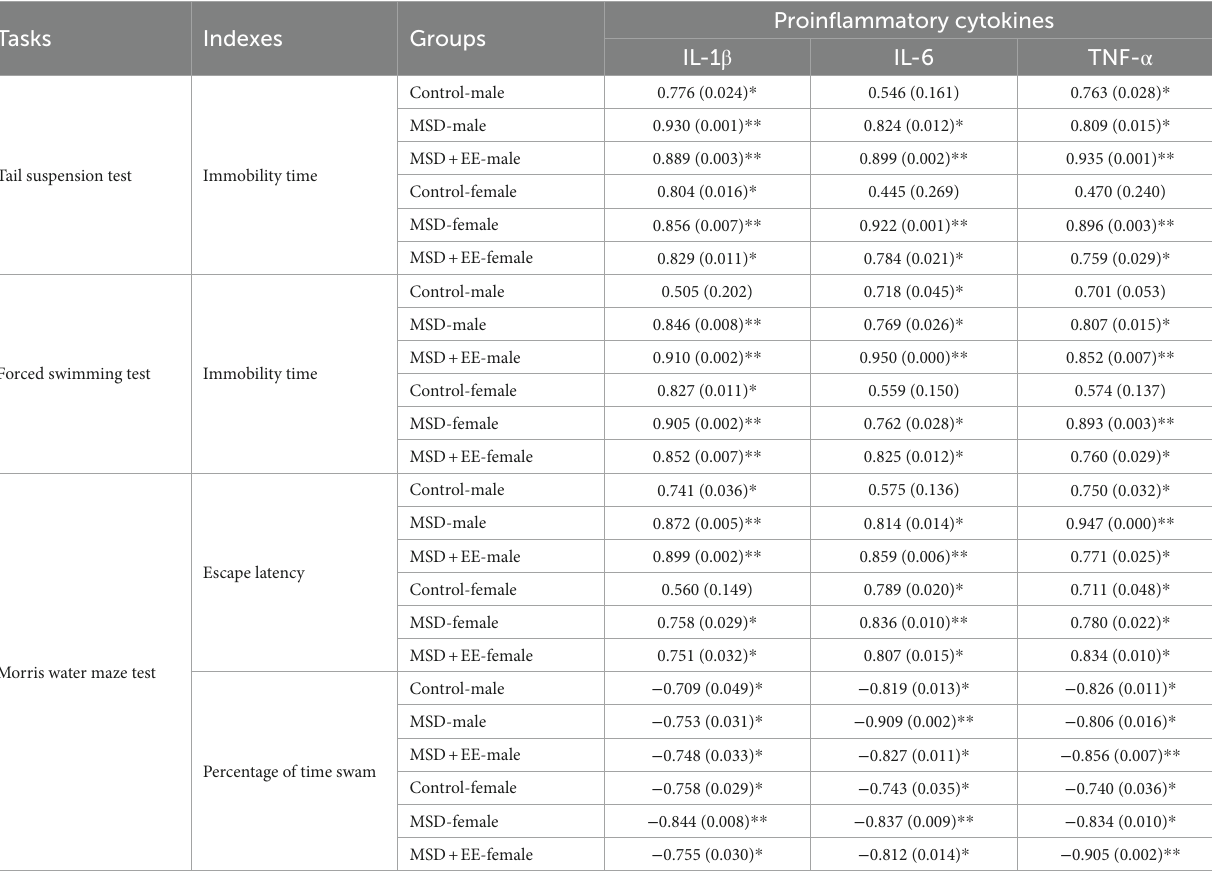
TABLE 1 Correlations between performance in the depression/cognition-related tasks and hippocampal proinflammatory cytokines.